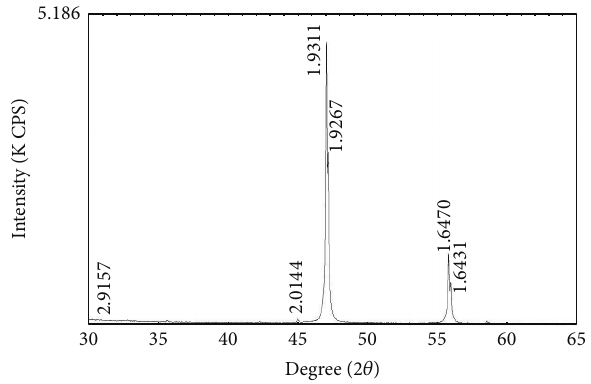
Figure 2: XRD pattern of